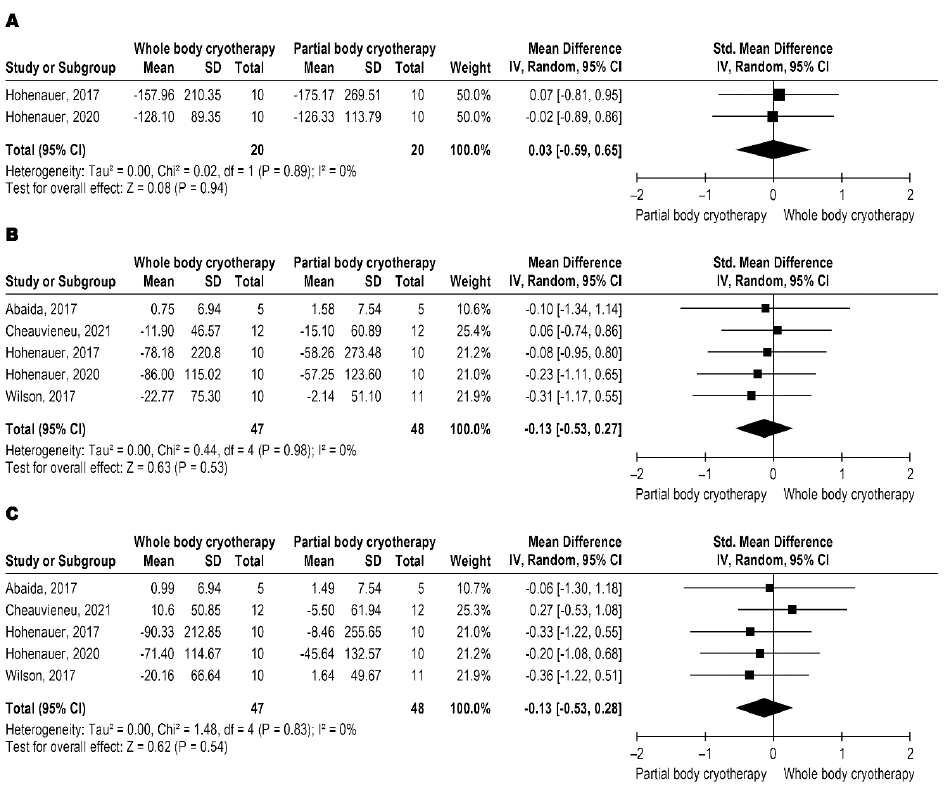
Figure 2. Metanalysis comparison between WBC and PBC for MVIC ( A ) immediately-post interven- tion [5,16], ( B ) 24 h after intervention [5,13,16,20,25], and ( C ) 48 h after intervention [5,13,16,20,25].